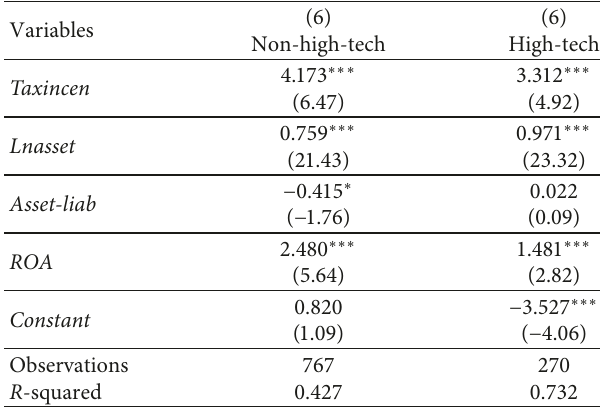
Table 6: Tax incentive policies-innovation input (high-tech) model.